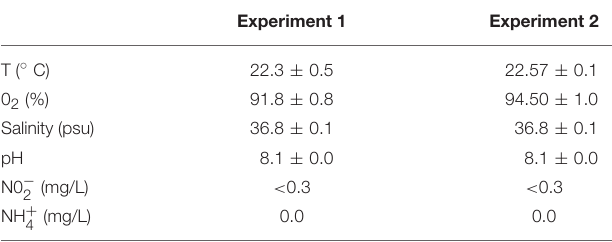
TABLE 1 | Physicochemical parameters for paralarvae reared. Experiment